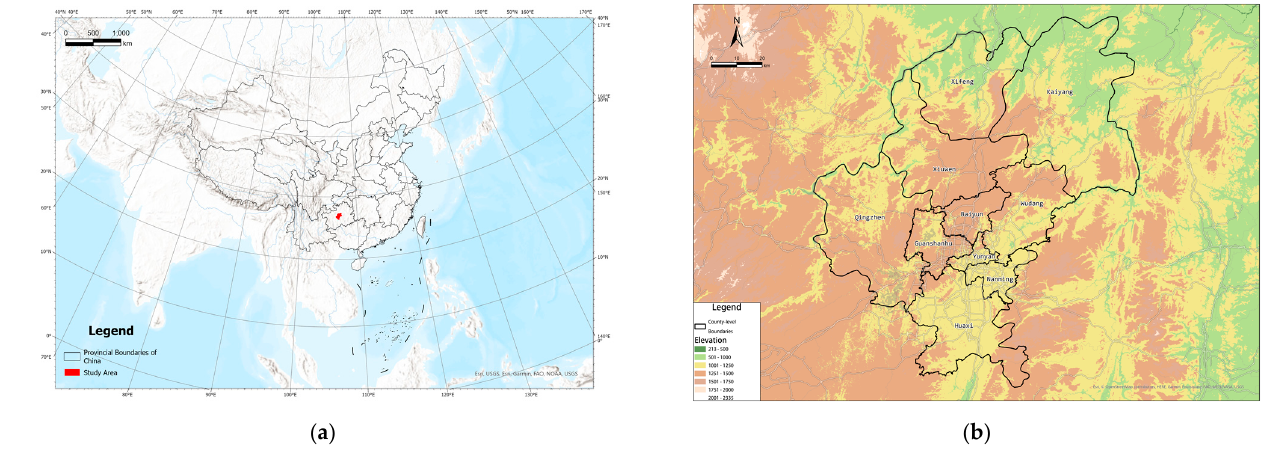
Figure 5. Location of Guiyang. ( a ) Prefectural area. ( b ) Counties of Guiyang.